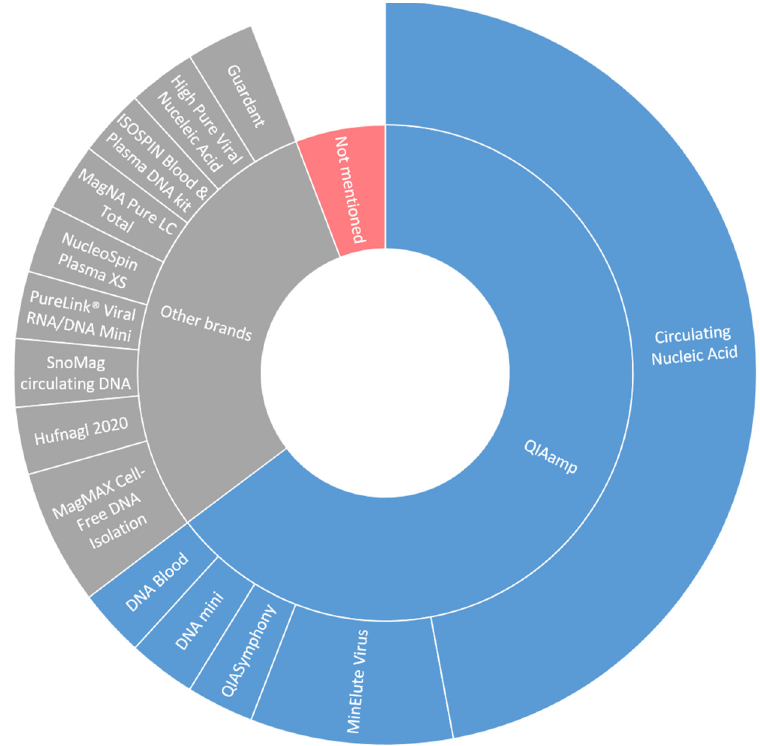
Figure 3. DNA isolation techniques in included studies.